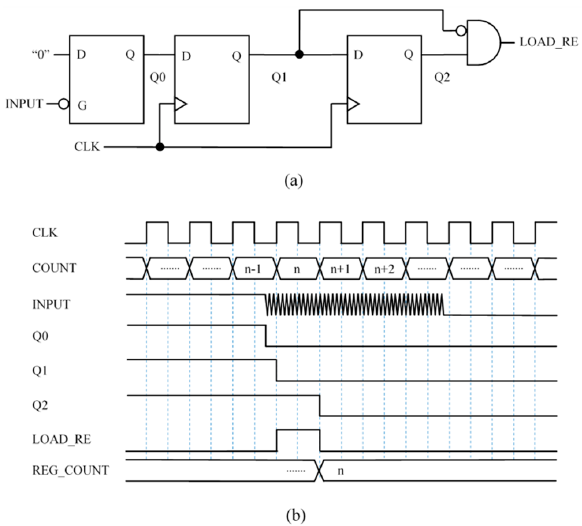
Figure 7. Capture Module 3—Circuit based on front end interface with latch: ( a ) circuit and ( b ) example chronogram.